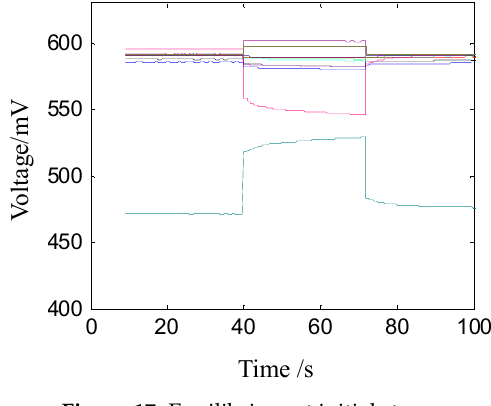
Figure 17. Equilibrium at initial stage.